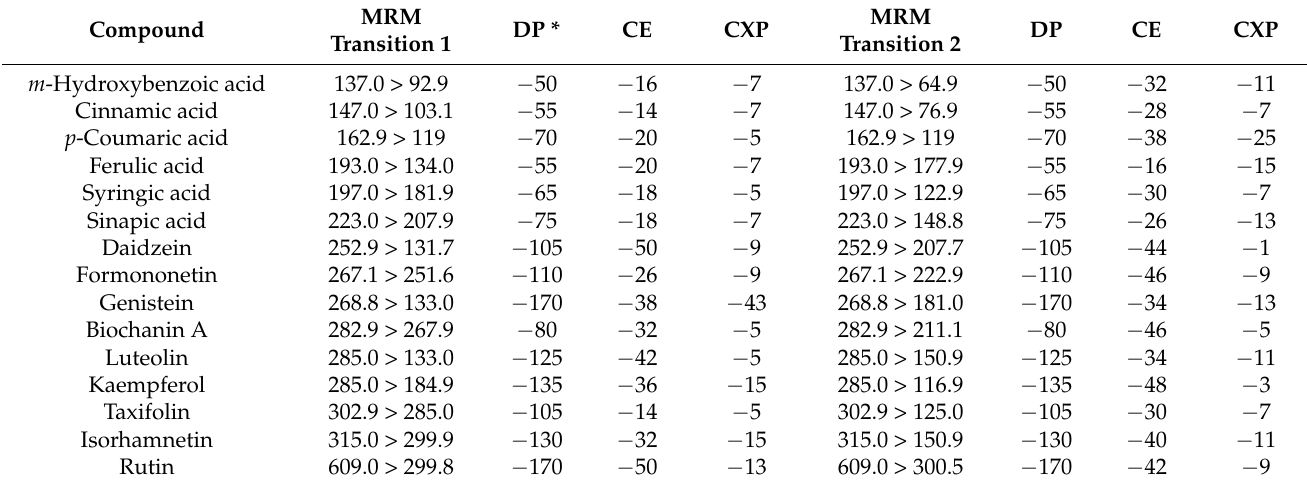
Table 1. Parameters used for the LC–MS/MS analysis of the phenolics